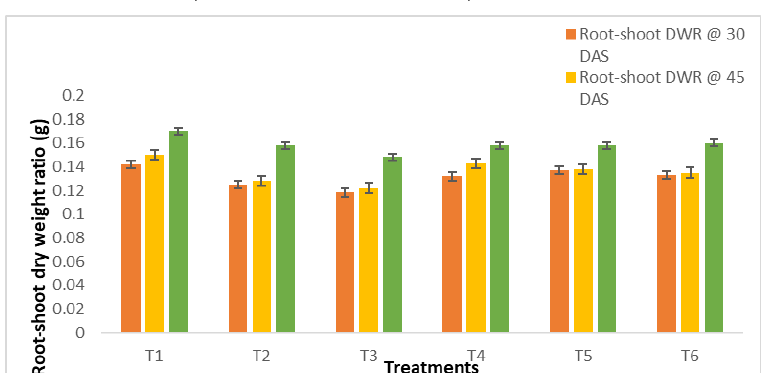
Figure 8. Effects of NPK consortia biofertilizer and chemical fertilizers on mean of root-shoot dry weight ratio at different growth stages; DWR = Dry Weight Ratio, DAS = Days after